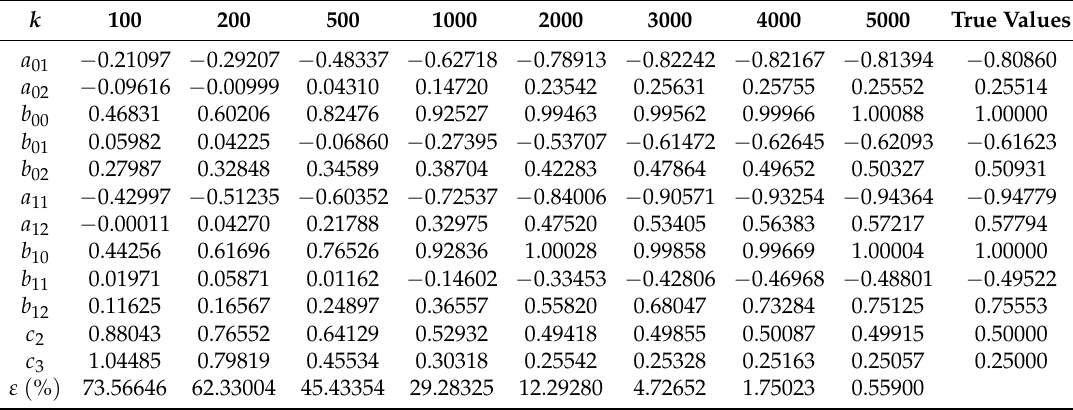
Table 3. The AM-MISG parameter estimates and errors ( p =